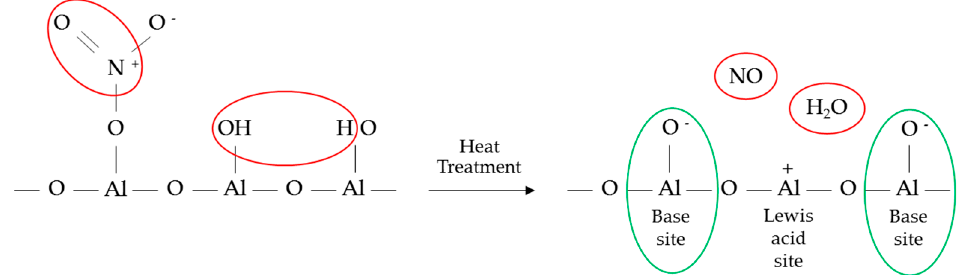
Table 5. Ammonia (NH 3 ) TPD acid characteristics of samples S1 HT , S2 HT , and